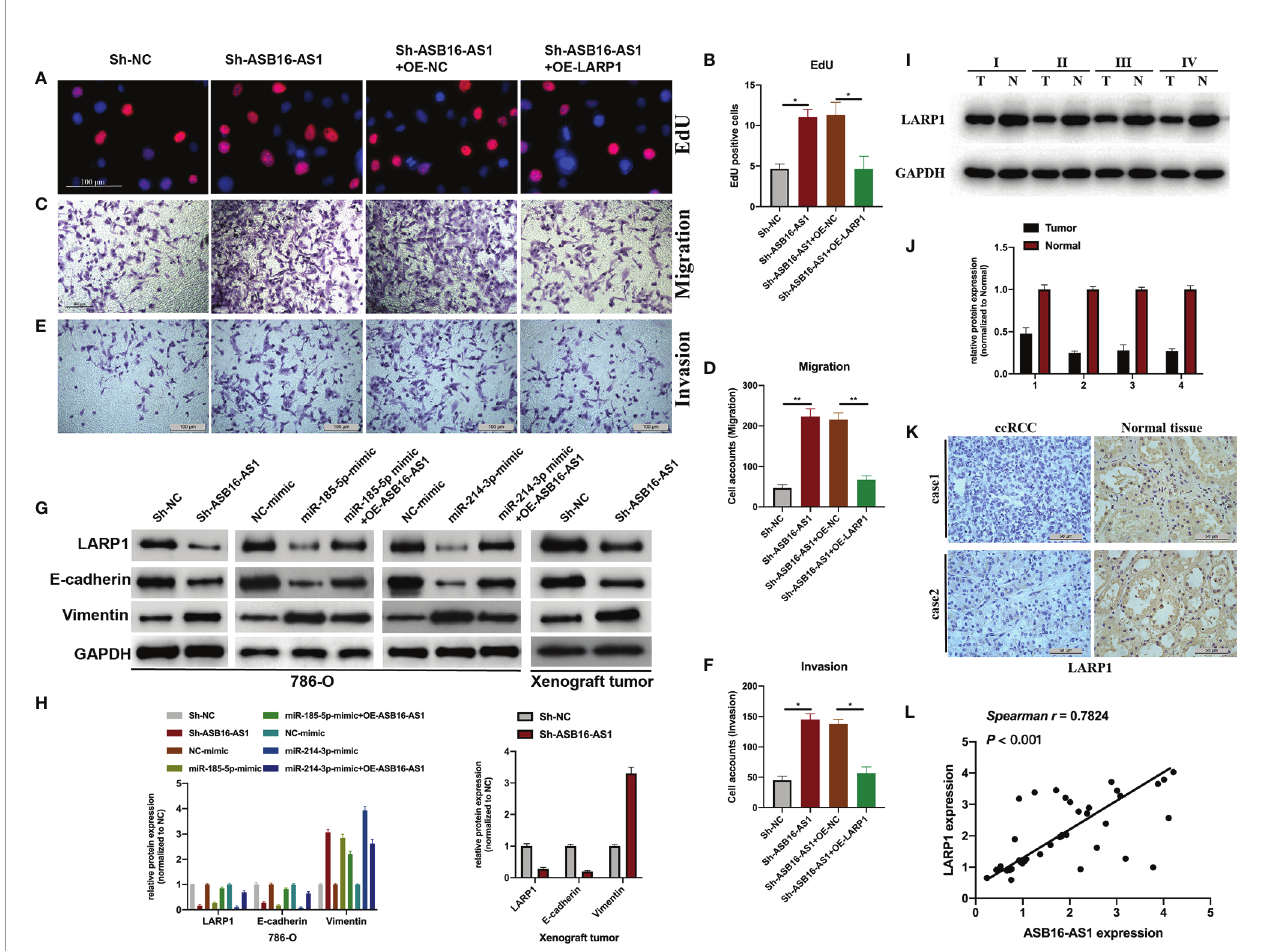
FIGURE 7 | Downregulated ASB16-AS1 promotes ccRCC progression via the miR-185-5p/miR-214-3p-LARP1 pathway. 786-O cells were stably transfected with Sh-NC, Sh-ASB16-AS1, Sh-ASB16-AS1+OE-NC, and Sh-ASB16-AS1+OE-LARP1. (A, B) Determination of cell proliferation using EdU assays (Scale bars -100 m m). (C, D) Determination of cell invasion ability using Transwell migration assays (Scale bars -100 m m). (E, F) Determination of cell migration ability using Transwell invasion assays (Scale bars -100 m m). (G, H) Expression of the epithelial-mesenchymal-transition associated proteins E-cadherin and Vimentin were detected by western blot assays. (I, J) Expression of LARP1 in four ccRCC tumor tissues and its adjacent normal tissues, which were randomly selected, were detected using western-blot. (K) Expression of LARP1 in two ccRCC tumor tissues and its adjacent normal tissues, which were randomly selected, were assessed using IHC assay (Scale bars -50 m m). (L) The expression correlation between ASB16-AS1 and LARP1 were analyzed using spearman statics. *P < 0.05, **P <